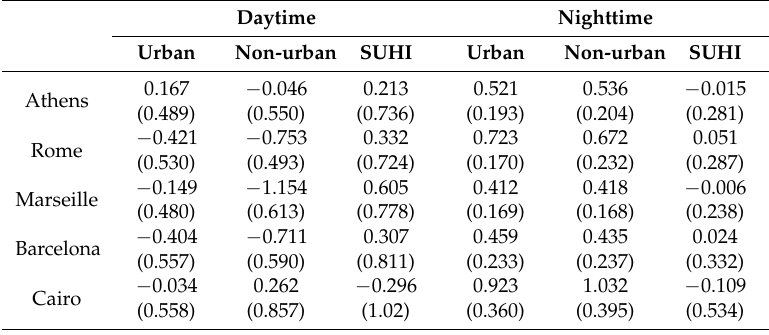
Figure 11. LST trend values (in °K) of the non-urban pixels of Athens (Nighttime). Table 2. Average urban, non-urban LST and Surface Urban Heat Island (SUHI) trend values in Kelvin and standard deviations in parenthesis.